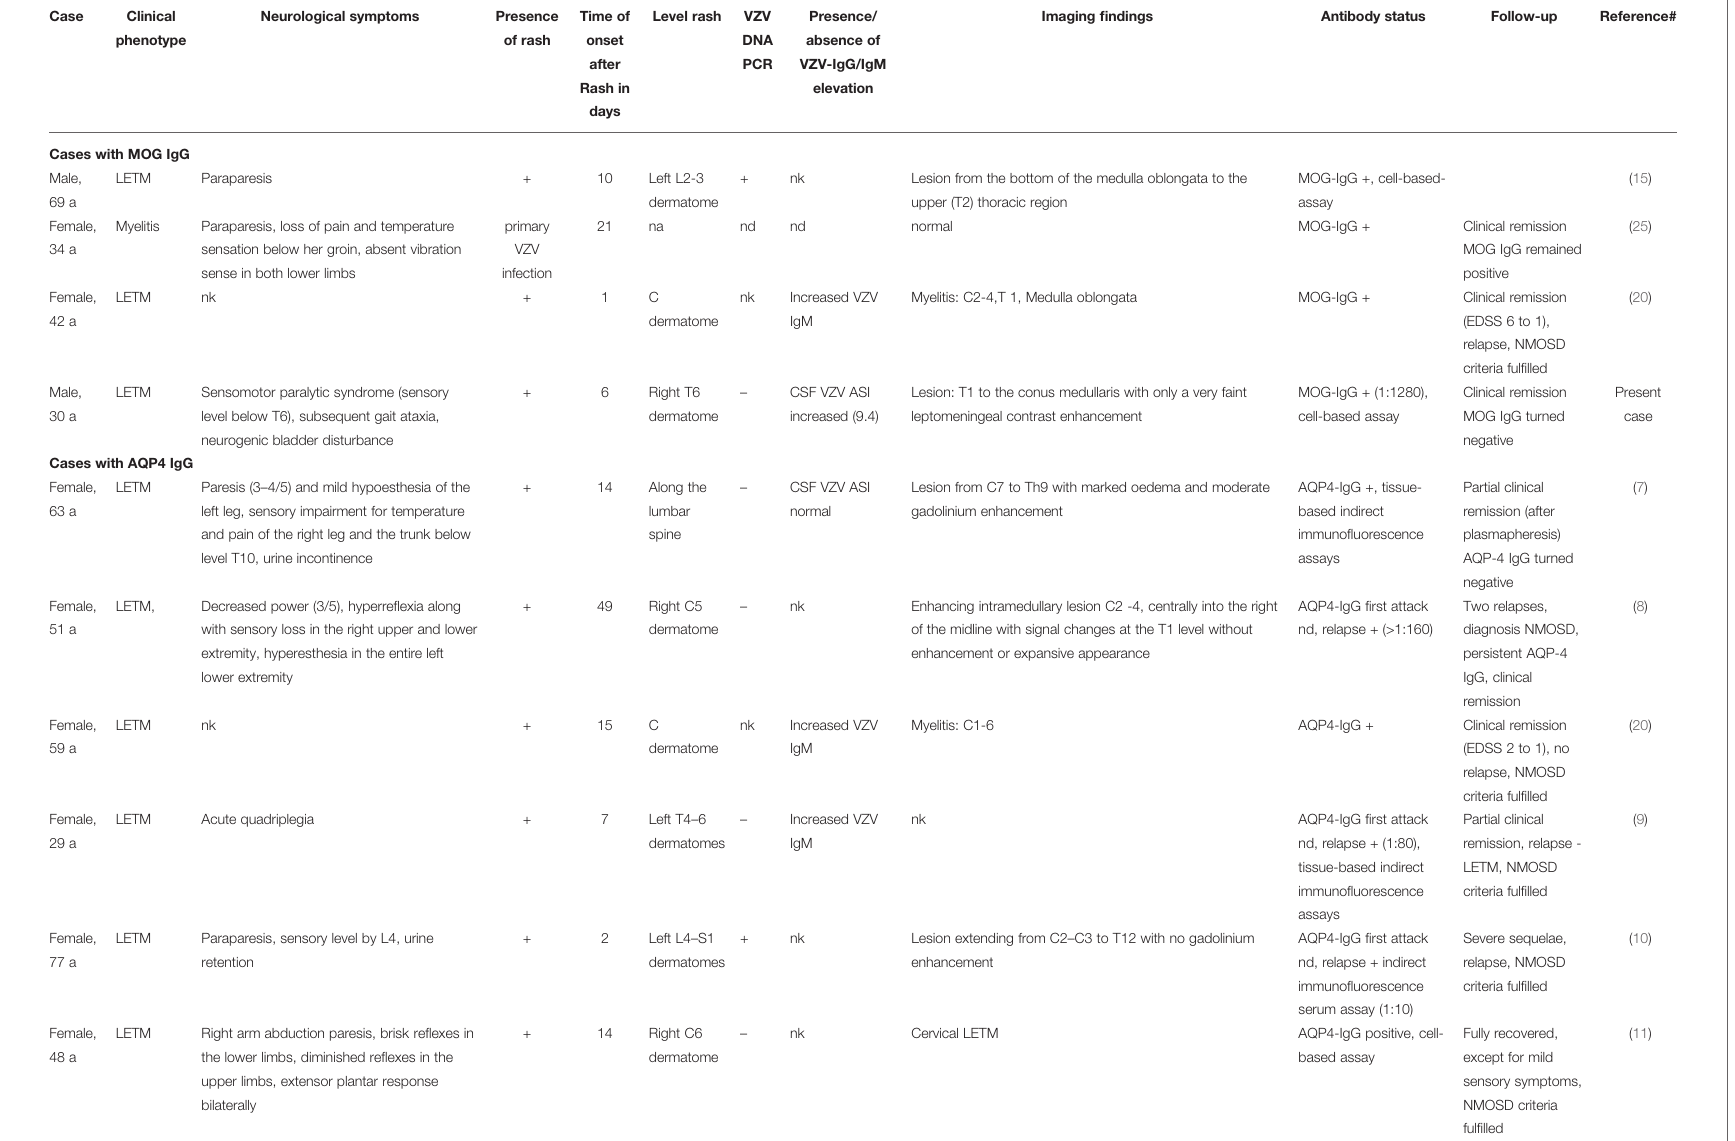
TABLE 3 | Varicella zoster virus infection-associated cases with MOG/AQP4 antibody associated central nervous system